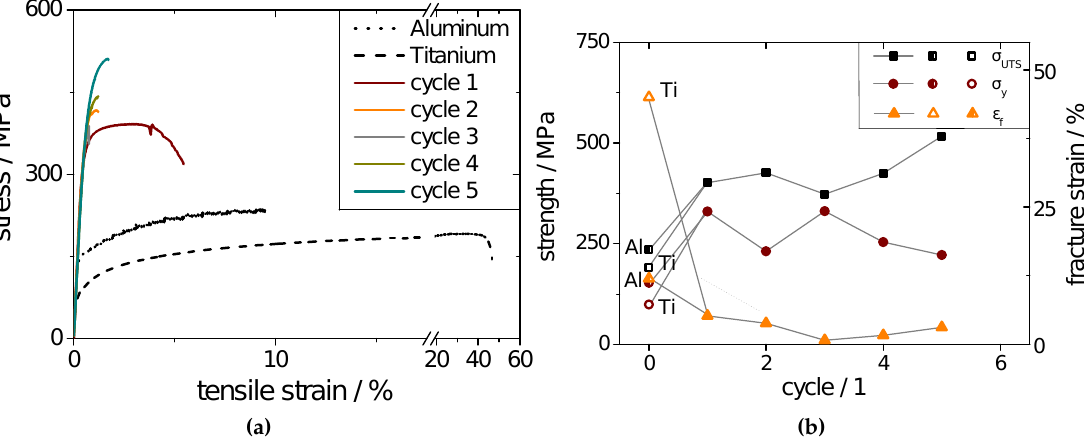
Figure 3. Engineering stress-strain curves of the five-layered Ti/Al composite accumulatively roll bonded with up to five cycles without intermediate heat treatments ( a ) and ultimate tensile strength ( σ UTS ), yield strength ( σ y ) and plastic strain ( ε ) of Al (half open symbols), Ti (open symbols) and the five-layered composite (filled symbols) ( b